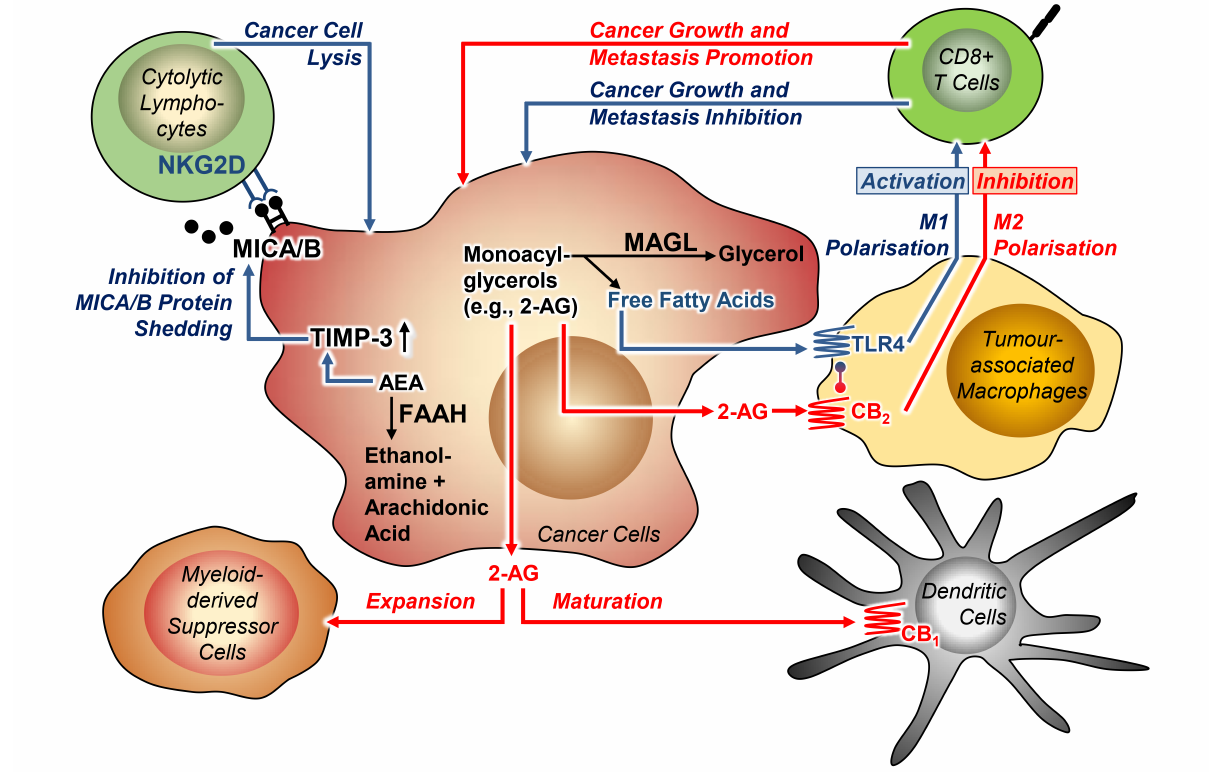
Figure 2. Effects of MAGL and FAAH on tumour-immune interactions. Blue arrows indicate benign effects, red arrows indicate effects that cause cancer progression. Lines with circles at the ends indicate receptor interaction. All abbreviations are explained in the